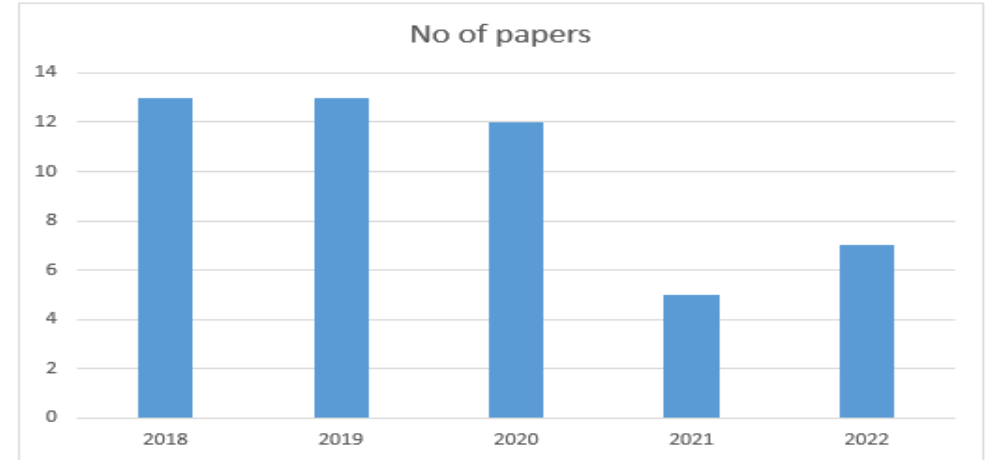
8 of 23 Table 3. The search query process. Phase